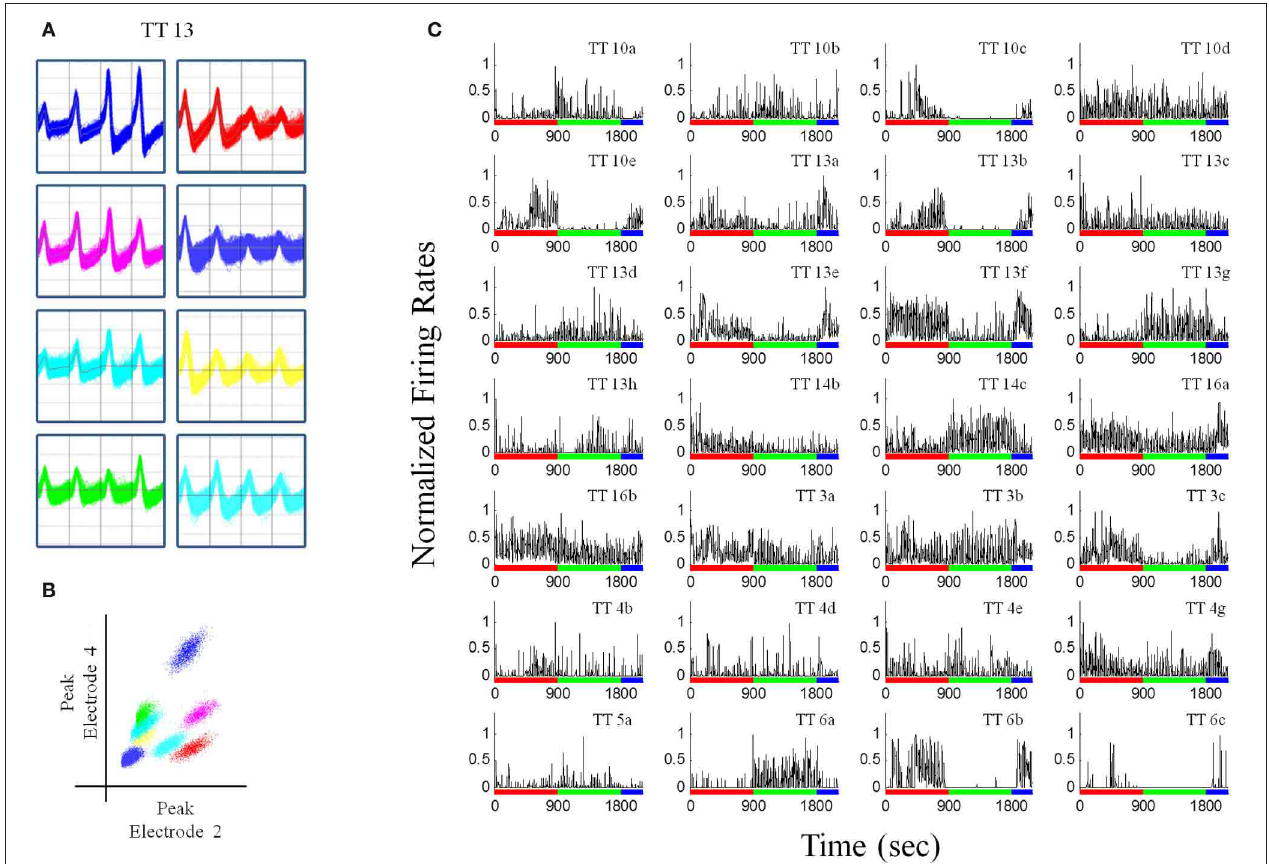
FIGURE 3 | Recordings from a pellet drop session. (A) Waveforms recorded from a single tetrode (tetrode #13). (B) Plot of peak waveforms from two electrodes of tetrode 13 showing clustering indicative of putative individual units. Tetrode 13 was chosen because it had the largest number of putative individual units. (C) Normalized firing rates for unit recordings in one